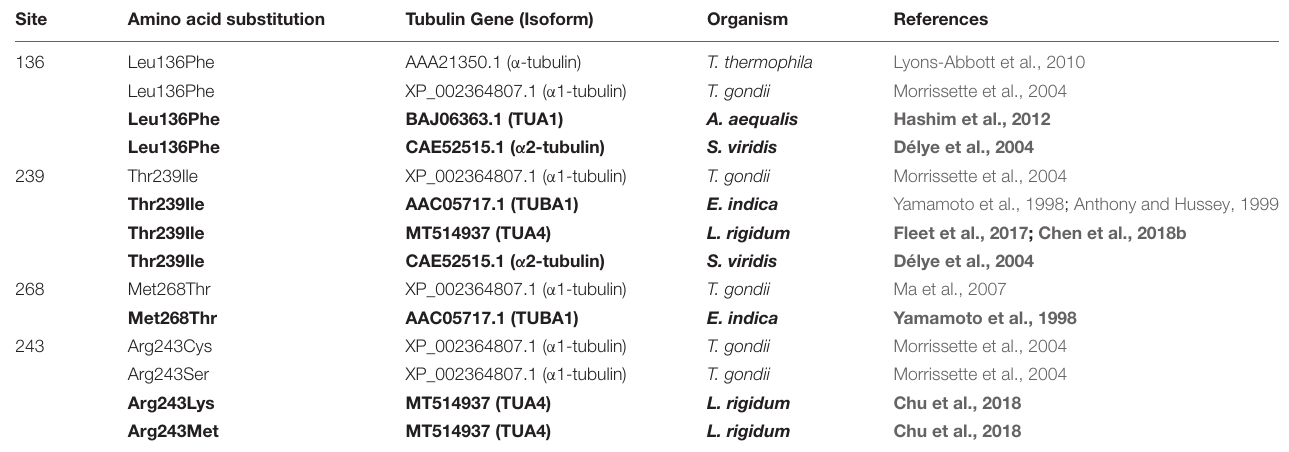
TABLE 2 | Common α -tubulin mutations and mutation sites shared by the protozoan Toxoplasma and higher plants.